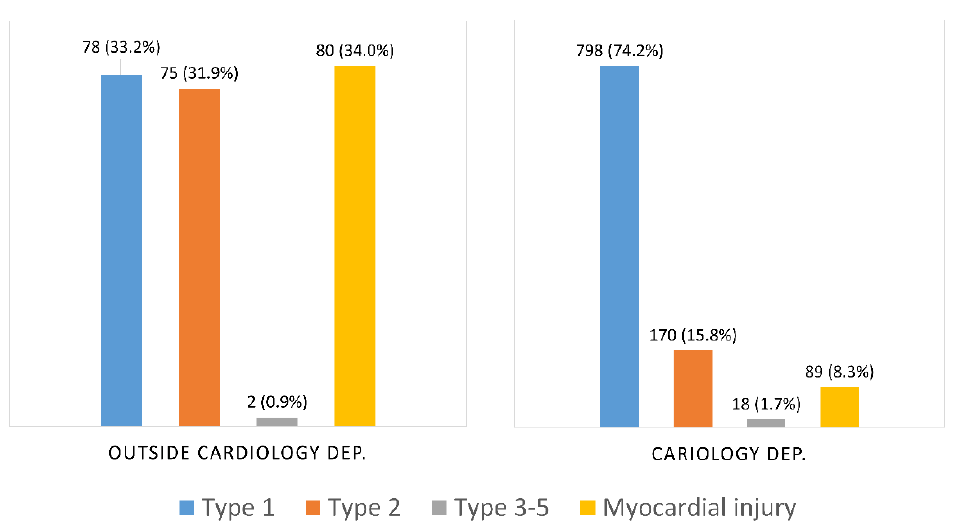
Figure 3. Prevalence of myocardial infarction types outside CDs and at CDs.